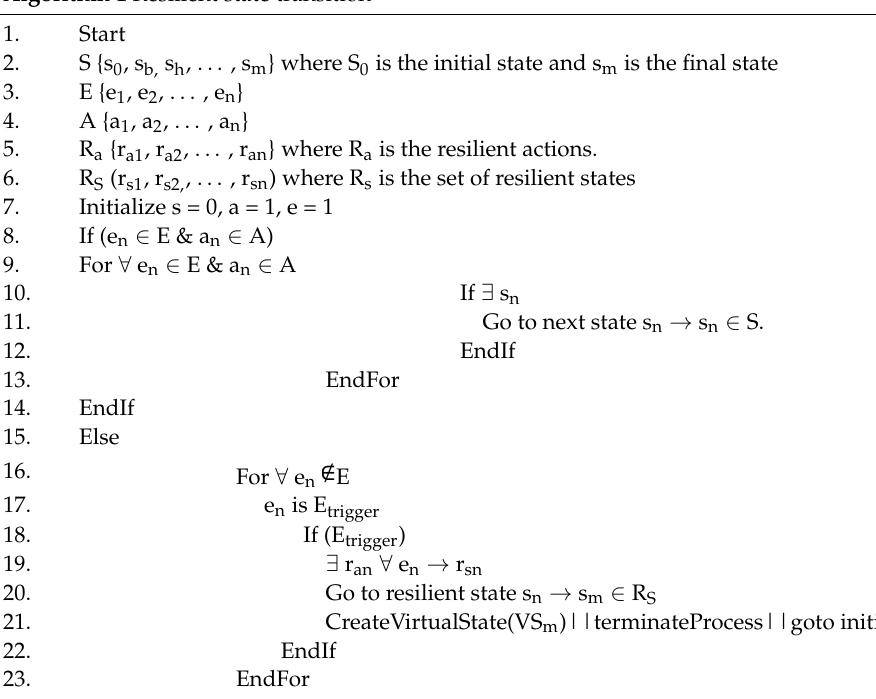
Figure 6. Example of an R-STD for environmental